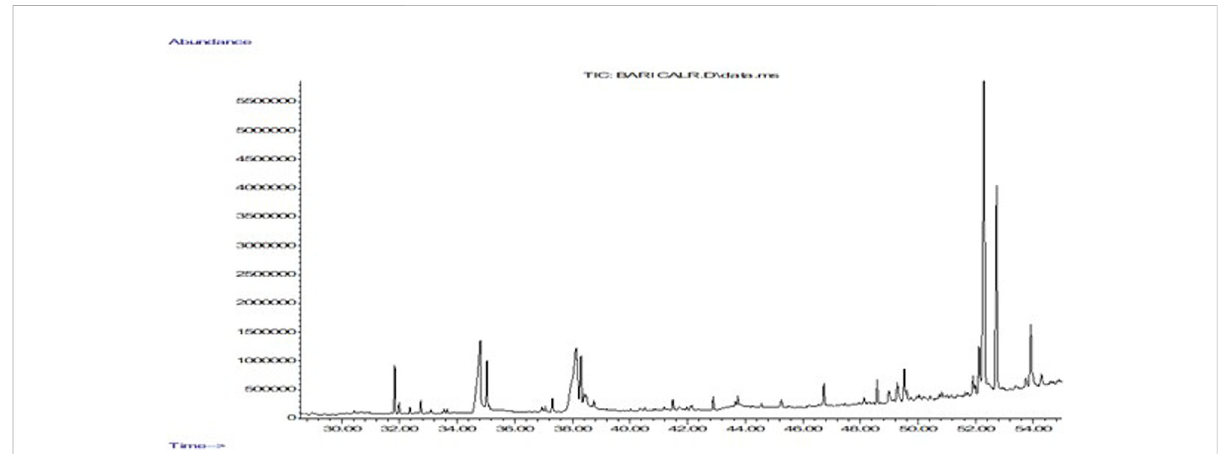
FIGURE 7 Gas chromatography mass spectrometry analysis of ethanol extract of Colligonum comosum. Image depicts a representative chromatograph of constituents identi fi ed by GC/MS in in EECC. Peaks represent absolute abundances, whereas numbers on the x -axis represent retention times in min.